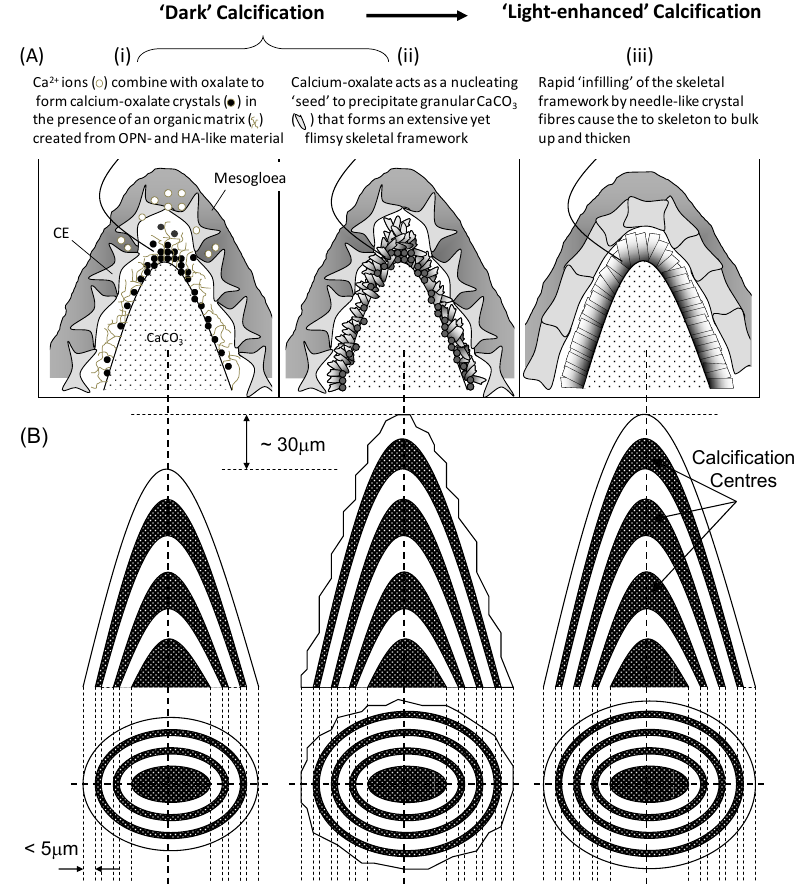
Fig. 6. Conceptual representation of the new biomineralisation model. (A(i)) During “dark” calcification the CE is biologically active, with the cells becoming highly interdigitated, thereby creating large intercellular spaces into which the mesoglea extends and ramifies (Johnston 1980). Ca 2 + ions, oxalate, and calcium binding substances (e.g., HA and OPN) are secreted into the ECF by the cells of the CE (either directly or via the mesogloea) – weighted most heavily towards the tip region. The secretion mechanism(s) remains to be determined. The HA- and OPN-like substances act to form an organic matrix which helps to bind calcium-oxalate. (A(ii)) The calcium-oxalate crystals serve as a nucleating site for the formation of aragonitic CaCO 3 crystals. (A(iii)) Major epitaxial growth of the aragonite fibres occurs during the “light-enhanced” period of calcification, which benefits from the energy-dependent functioning of the Ca 2 + -ATPase enzyme. During this period, the CE forms well-defined lateral cell borders with the mesogloea (Johnston, 1980). (B) With length scales of tens of micrometers, aragonite fibres grow as a superimposed succession of repeated organo-seed → inorganic crystal interactions across multiple diurnal (24h)